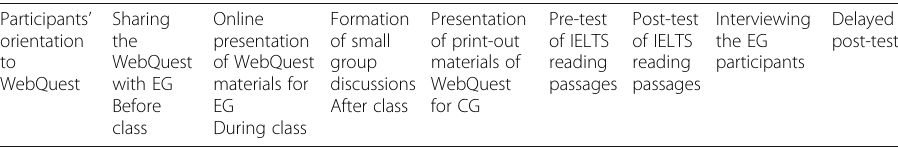
Table 2 Schematic presentation of the steps taken in the procedure Participants ’ orientation